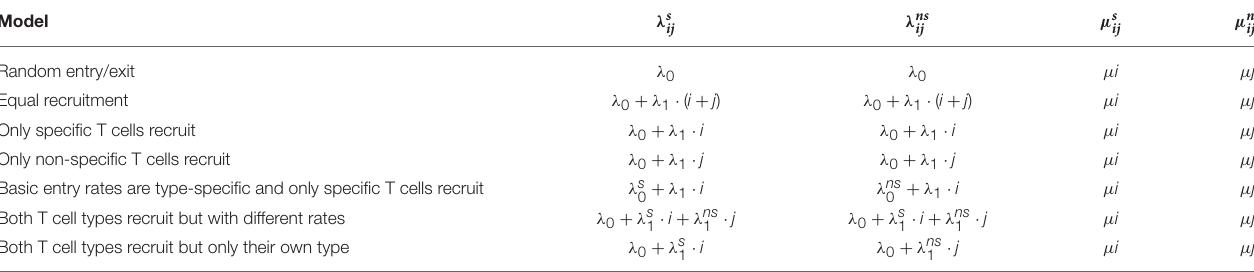
TABLE 1 | Defining alternative models for co-clustering of Plasmodium-specific ( s ) and non-specific ( ns ) T cells around Plasmodium liver stages.